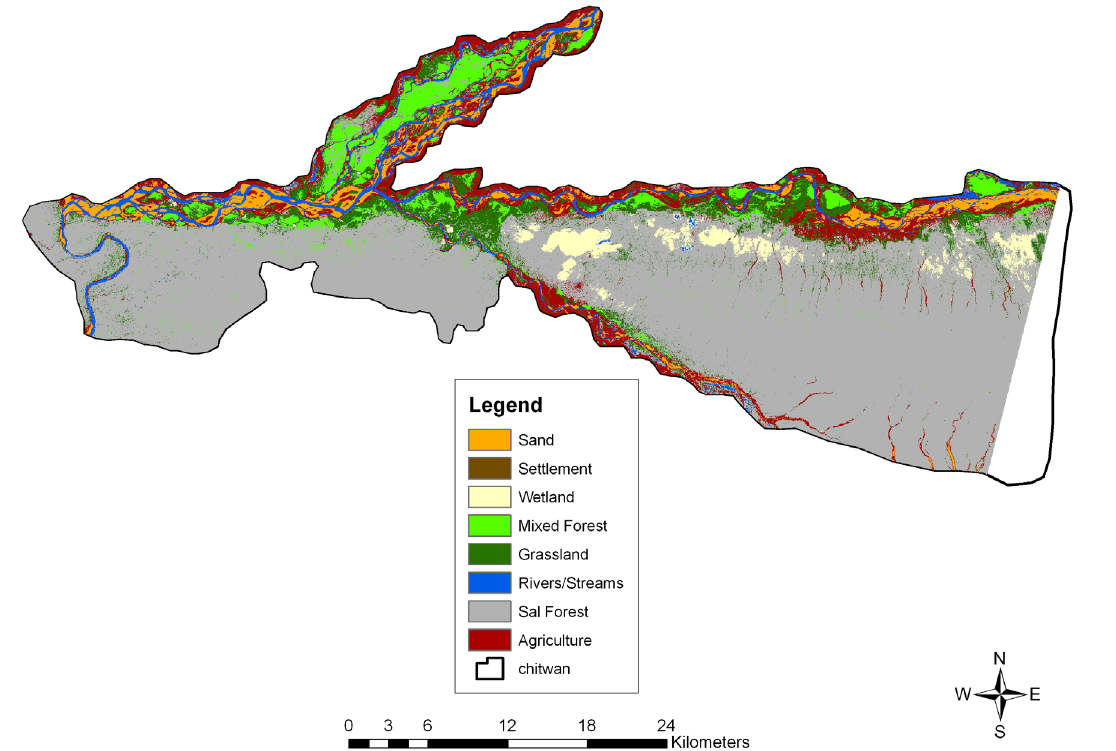
Figure 2. Supervised classified image of